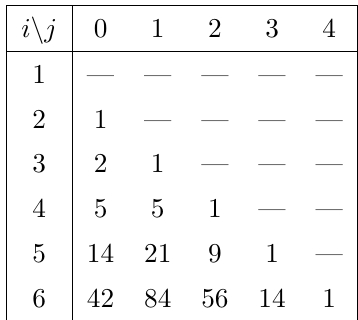
Table 1 . Number triangle showing the number of j -dimensional faces T ( i; j ) of the associahe- dron K i